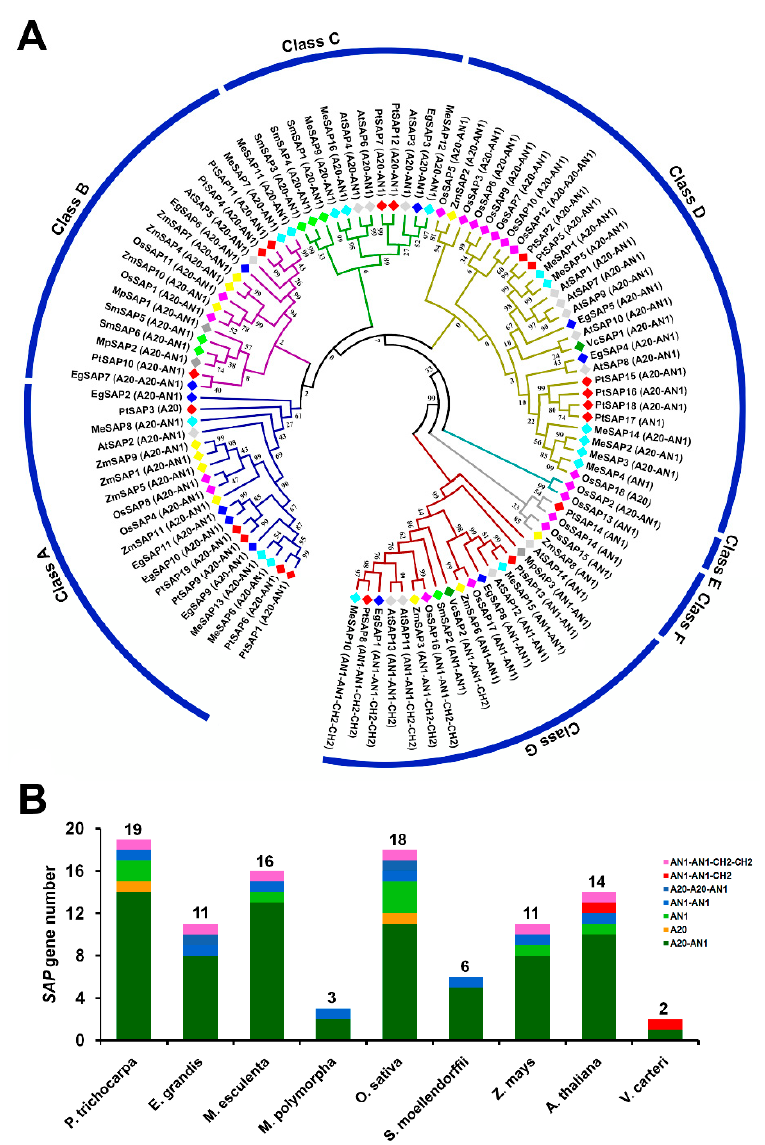
Figure 1. The SAP gene family underwent gene expansion in evolution history. ( A ) Phylogenetic tree and evolutionary relationship of the SAPs from Populus trichocarpa (Pt), Eucalyptus grandis (Eg), Manihot esculenta (Me), Marchantia polymorpha (Mp), Oryza sativa (Os), Selaginella moellendorffii (Sm), Zea mays (Zm), Arabidopsis thaliana (At), and Volvox carteri (Vc). ( B ) The number of SAP genes and zinc finger domains in different plants. The detailed SAP gene information and protein sequences are listed in Table S1.